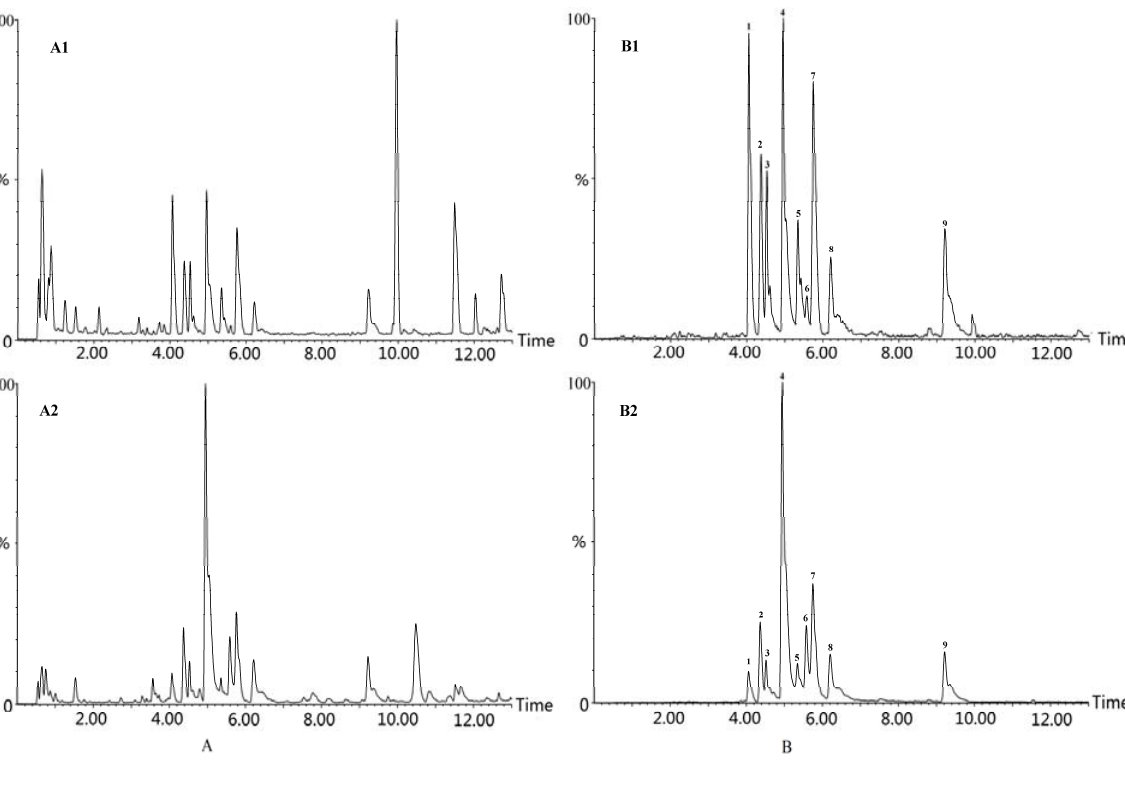
Figure 4. ( A ) UPLC-MS total ion chromatogram and ( B ) extracted ion chromatogram from the Xiaohuoluo pill . ( A1 , B1 ) Concentrated pill and ( A2 , B2 ) honey pill (1-delcosine, 2-isotalatizidine, 3-talatizamine, 4-benzoylmesaconitine, 5-aconosine, 6-benzoylaconine, 7-foresticine, 8-benzoylhypaconitine,